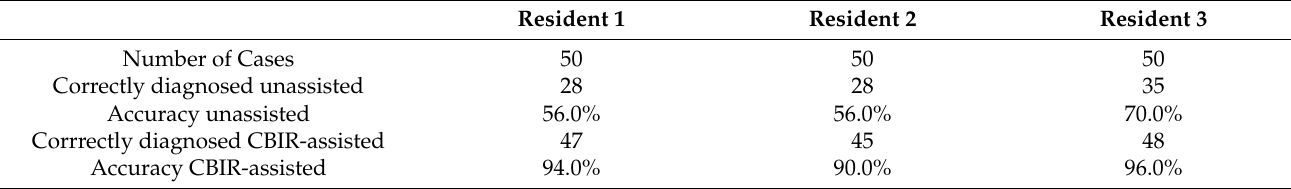
Table 2. Results of the residents’ accuracy. All residents’ accuracies in the unassisted test runs proved to be significantly different ( p < 0.01) from the CBIR-assisted test runs.